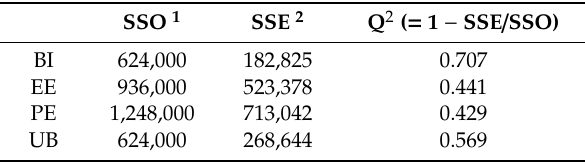
Table 5. Predictive relevance (cross-validated